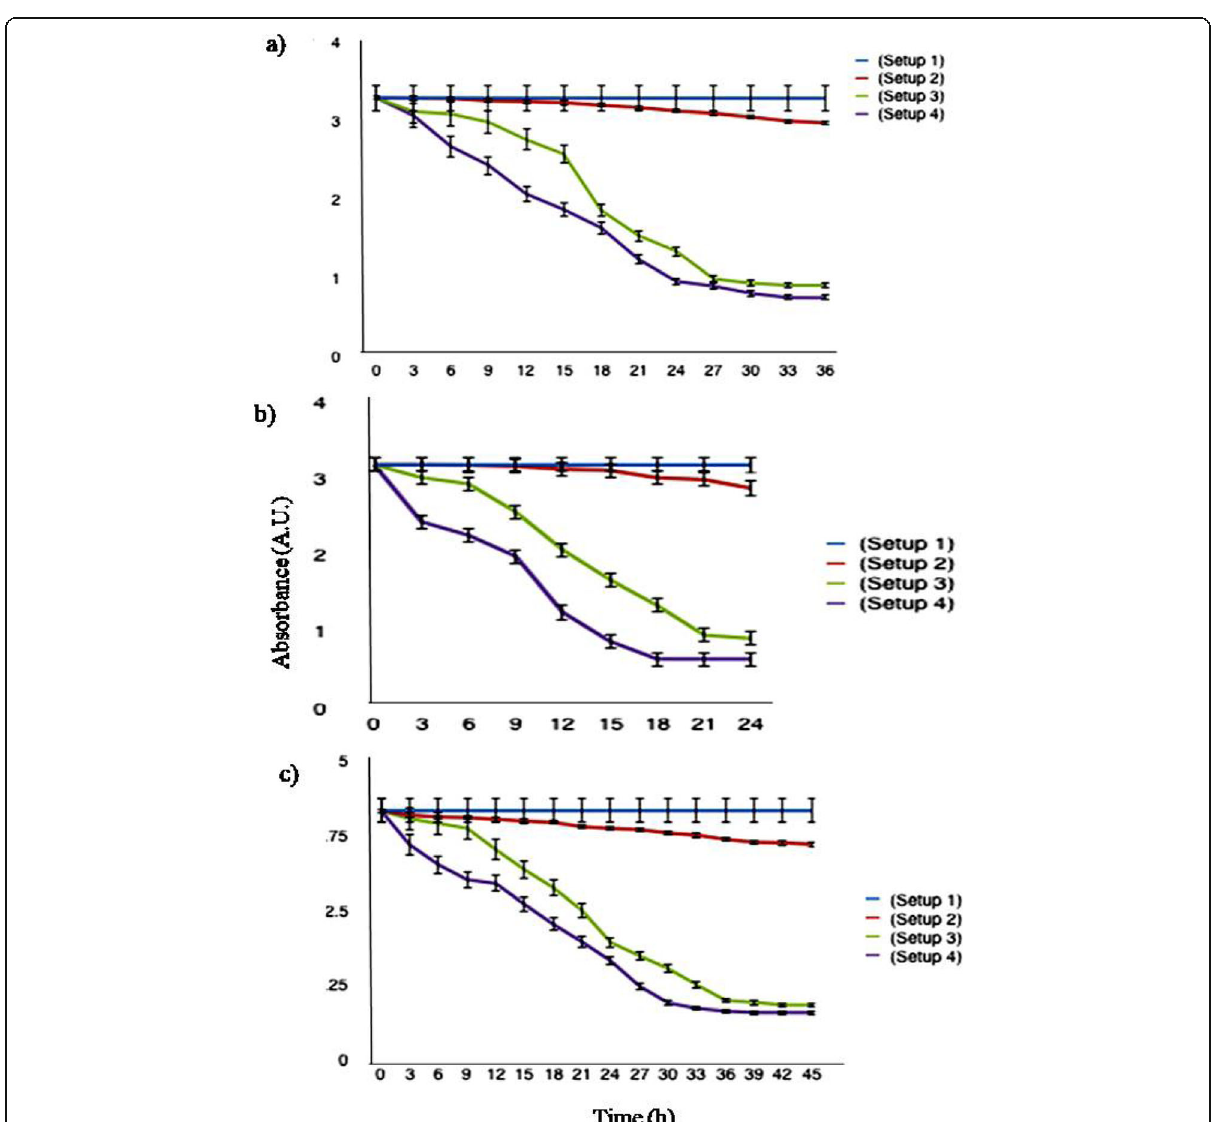
Fig. 9 Absorbance graph to evaluate the dye degradation of ( a ) Bromophenol Blue ( b ) Methyl Orange and ( c ) Coomassie Brilliant Blue for various